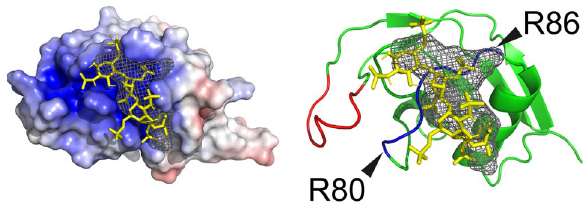
Figure 5. Cavity detection of HBD. The left panel shows HBDs colored by surface charge (blue: positive charge, red: negative charge) and their binding to heparin molecule (yellow). Detected cavity by POCASA is shown by the meshed structure. The cavity is positively charged and formed by novel heparin-binding site in blue (80–86) and adjacent α-helix. No cavity was detected for the known heparin-binding site in red (120–128). The protein structures were visualized by PyMOL Molecular Graphics System, Version 2.3.2 Schrödinger, LLC. https:// pymol. org.